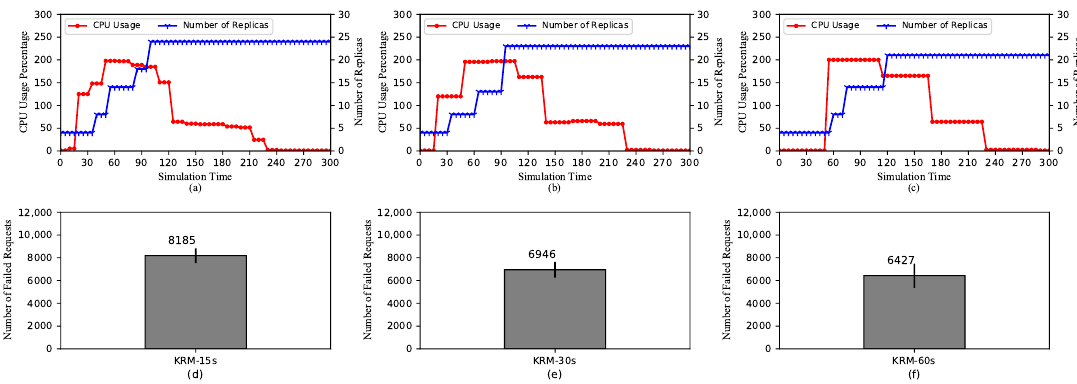
Figure 4. HPA using default Kubernetes Resource Metrics (KRM). ( a – c ) The average CPU usage and the scaling of the replica set for scraping periods of 15 s, 30 s, and 60 s, respectively. ( d – f ) The total number of the failed requests for scraping periods of 15 s, 30 s, and 60 s,